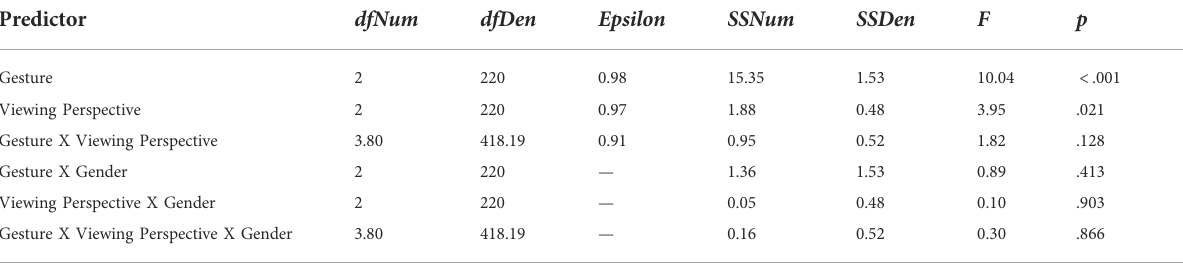
TABLE 6 Results of the mixed-measures ANOVA for the perceived hostility of the robot. Predictor